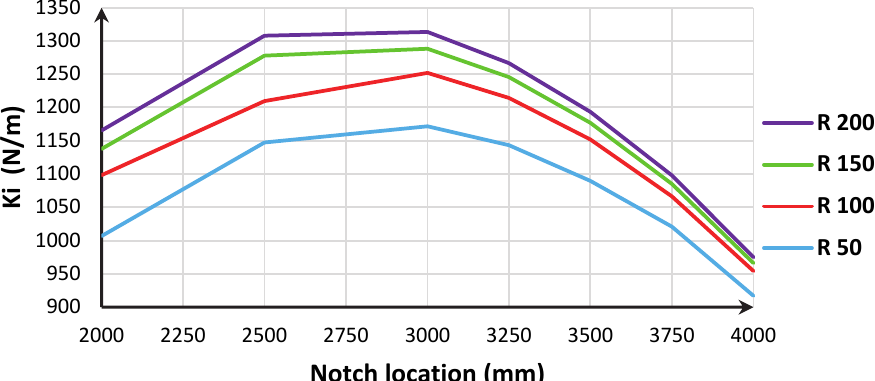
Figure 19: the effect of notch length and its location on the initial bending stiffness.